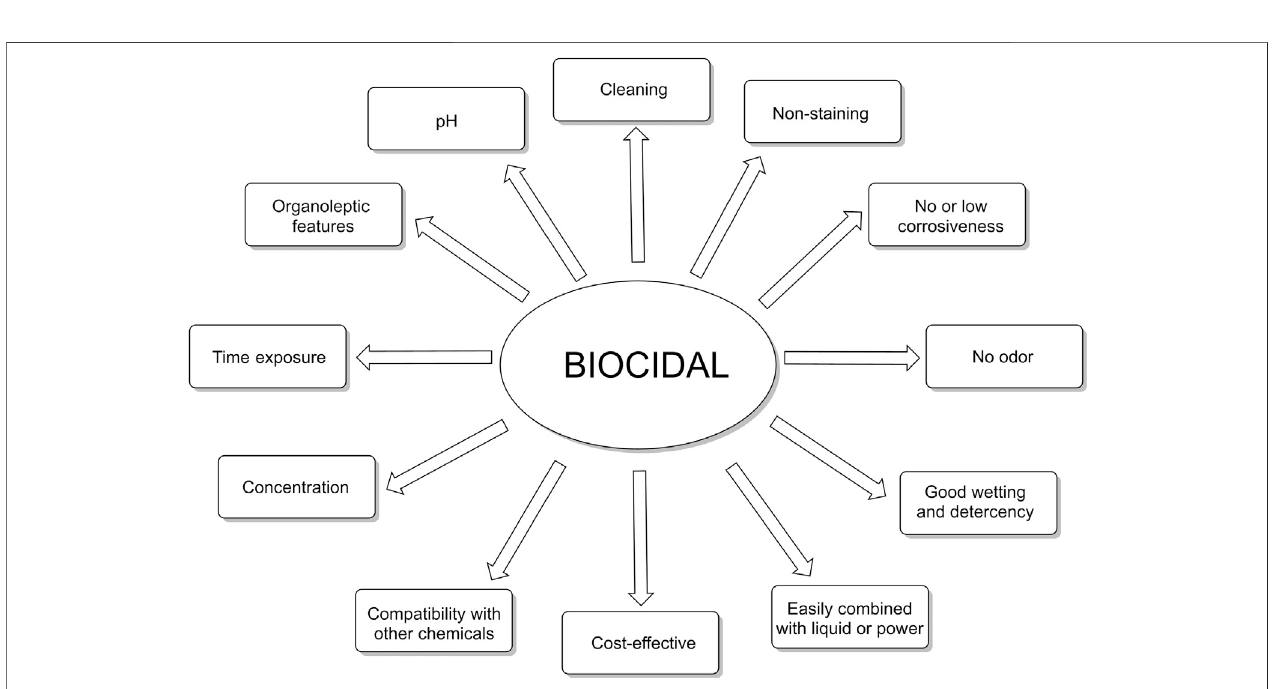
FIGURE 2 | Proposed antiviral mechanisms that NPs can use to contrast